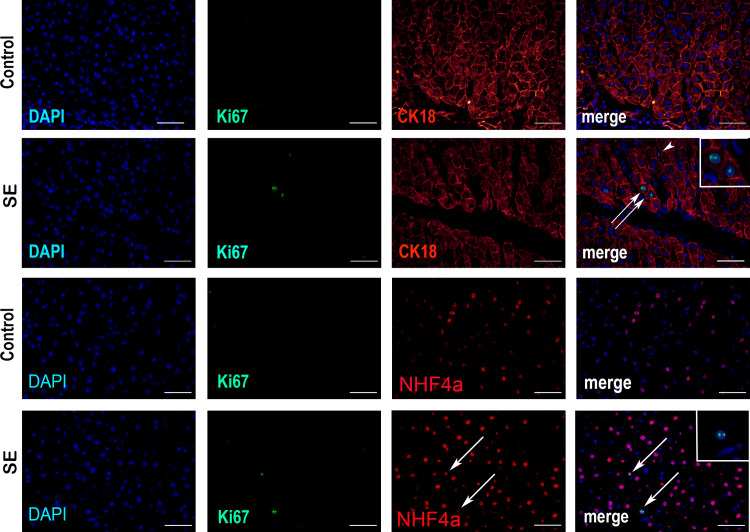
Splenectomy effects on cell proliferation in the liver.Cryosections of liver tissue after double anti-Ki67 (FITC) and anti-CK18 (PE) or anti-NHF4a (PE) immunostaining. The nuclei are counterstained with DAPI. Bars, 50 μm. Arrows indicate Ki67+hepatocytes, arrowheads indicate non-parenchymal Ki67+ cells.